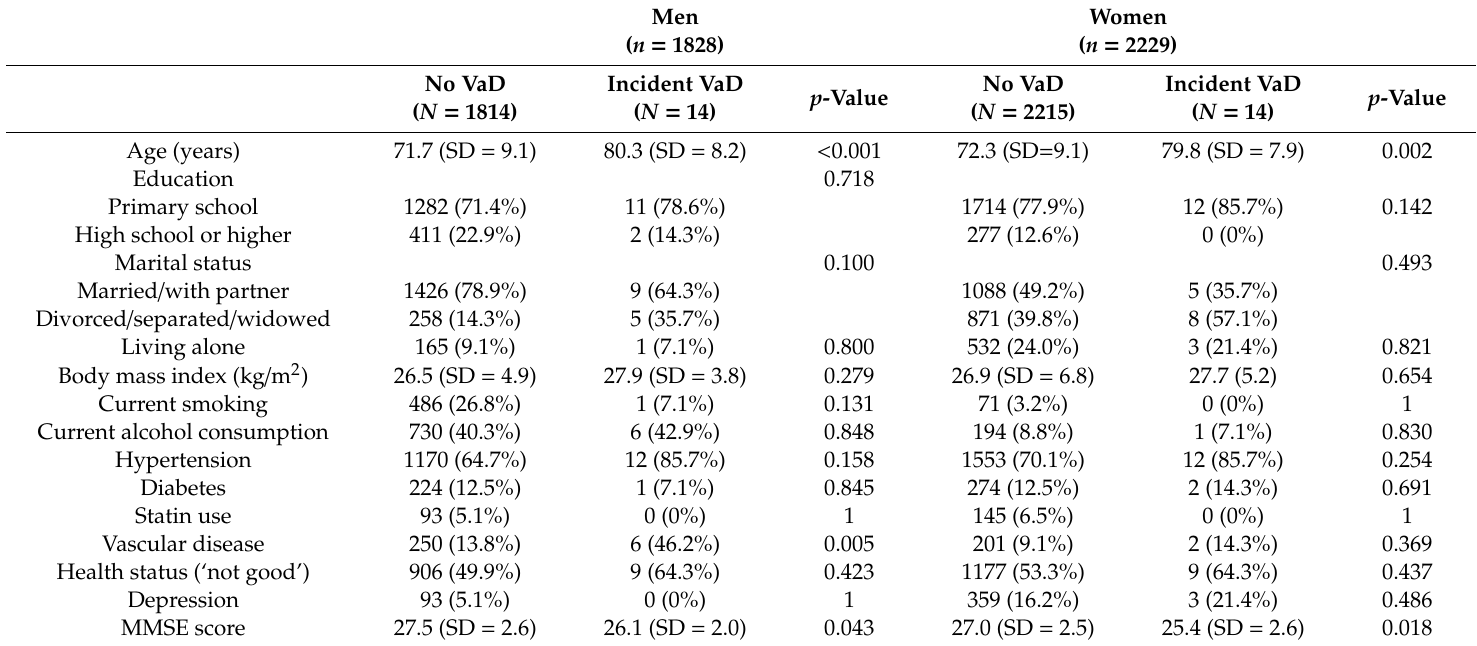
Table 1. Baseline characteristics according to incident VaD status stratified by